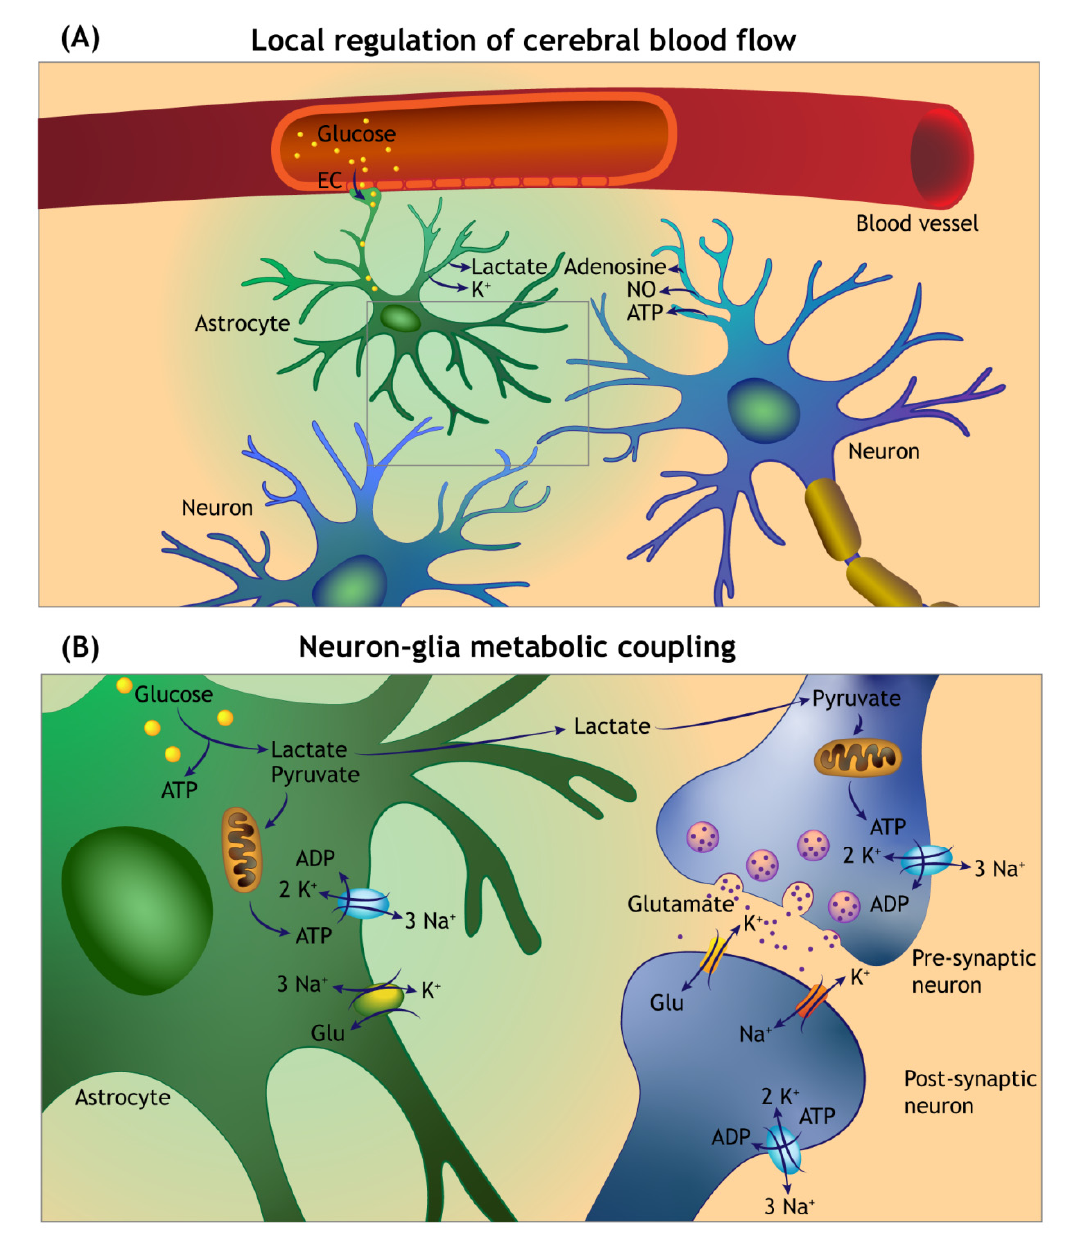
Figure 3. Overview of the local cerebral blood flow auto-regulation and neuron–glia metabolic coupling. ( A ) Neuronal and astroglia-derived vasoactive mediators act on the intraparenchymal capillaries and arterioles to sustain enhanced delivery of metabolic fuels during functional hyper- aemia. Circulating glucose enters into the brain parenchyma by facilitated diffusion via glucose transporters in the capillary endothelial cells (EC), and astroglial foot processes forming the glia limitans of the blood–brain barrier. ( B ) Glutamate uptake at the tripartite synapse by astrocytes is accompanied by sodium (Na + ) entry, which triggers anaerobic glycolysis and lactate release. The lactate is transferred to the neurons (via a process termed the Astrocyte Neuron Lactate Shuttle) and converted to pyruvate by neuronal lactate dehydrogenase (not shown). The pyruvate enters the citric acid cycle in mitochondria for ATP generation. A significant amount of the ATP generated is used to maintain the function of sodium–potassium pumps (Na + /K + -ATPase).